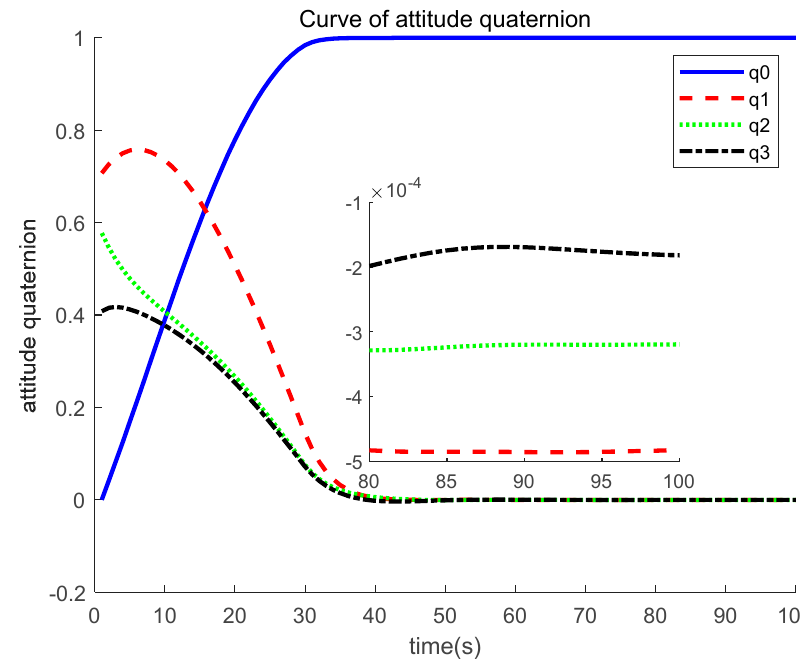
Figure 6. Curve of attitude quaternion under the controller proposed in this paper.